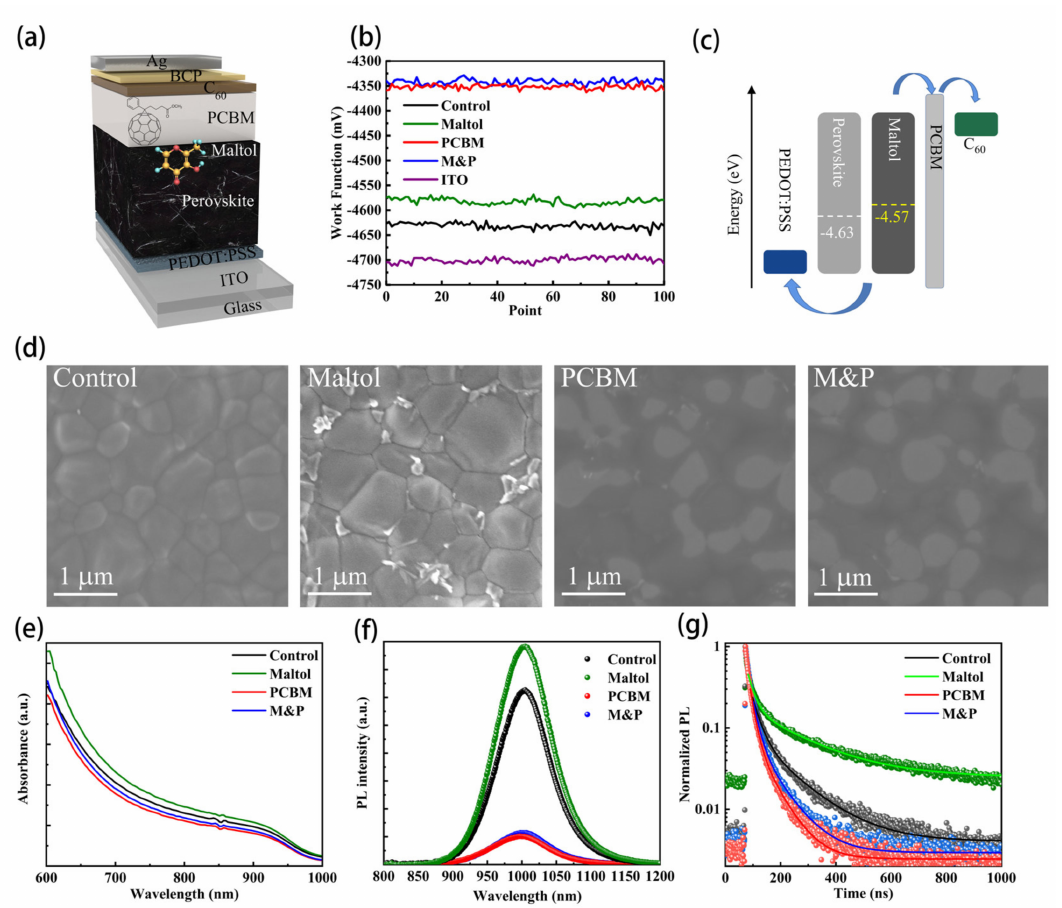
Figure 1. ( a ) Structure diagram of low-bandgap perovskite device with maltol and PCBM co- modification, ( b ) Surface work function profiles of the four different films, ( c ) Energy level diagrams of the maltol and PCBM co-modified device, ( d ) Top-view SEM images, ( e ) absorbance curves, ( f ) PL spectra, and ( g ) TRPL